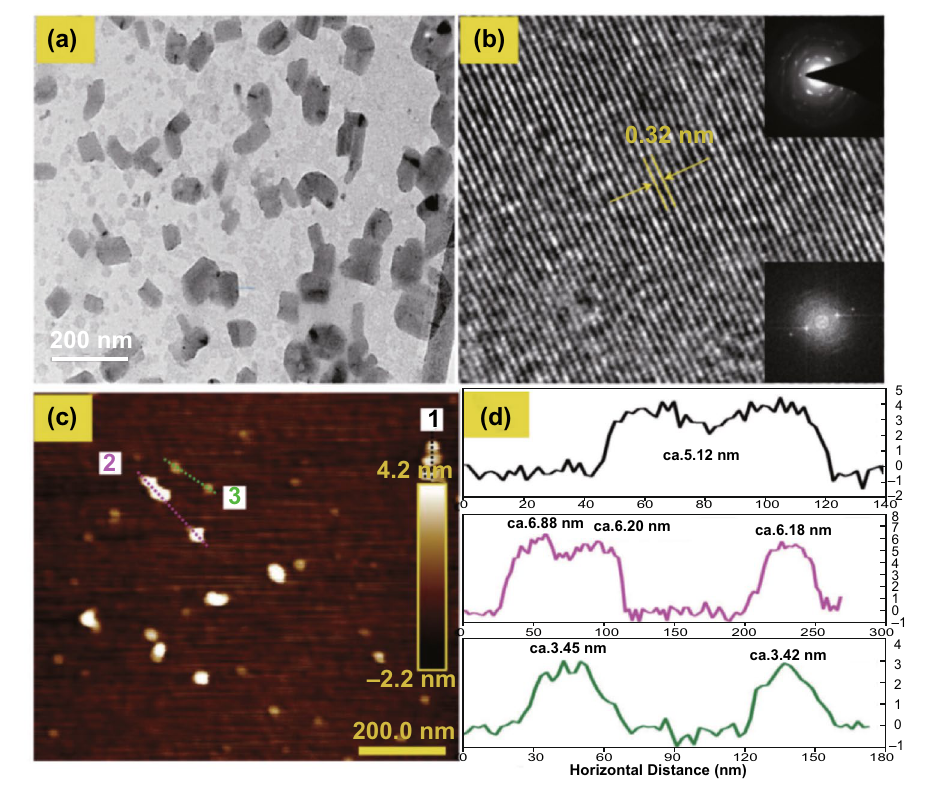
Fig. 5 a , b TEM and HRTEM images of the 2D Te nanoflakes. Insets of b : SED pattern and FFT photograph of the 2D Te nanoflakes (top and bottom). c AFM image of the ultrathin 2D Te nanoflakes. d Height profiles of the 2D Te nanoflakes presented in part c . Adapted with permission from [75]. Copyright 2018,